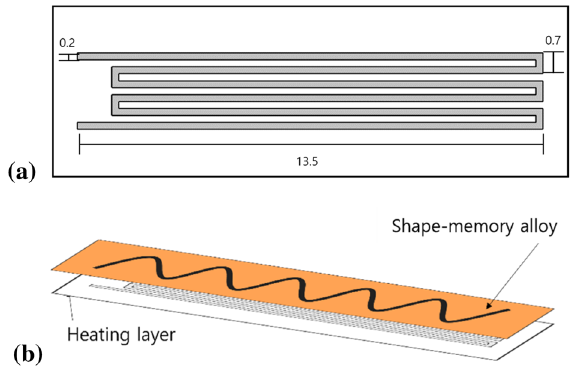
Fig. 1 Design of silver-paste layer ( a ), double-layer heating system ( b